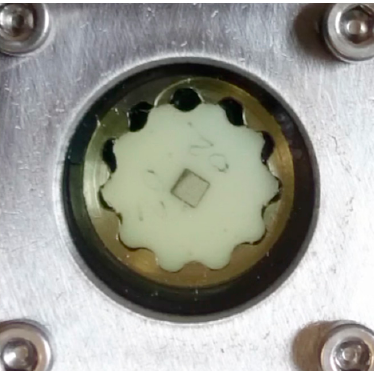
Figure 10. POM inner gear and sintered outer gear through an in house manufactured transparent polymer pump cover.